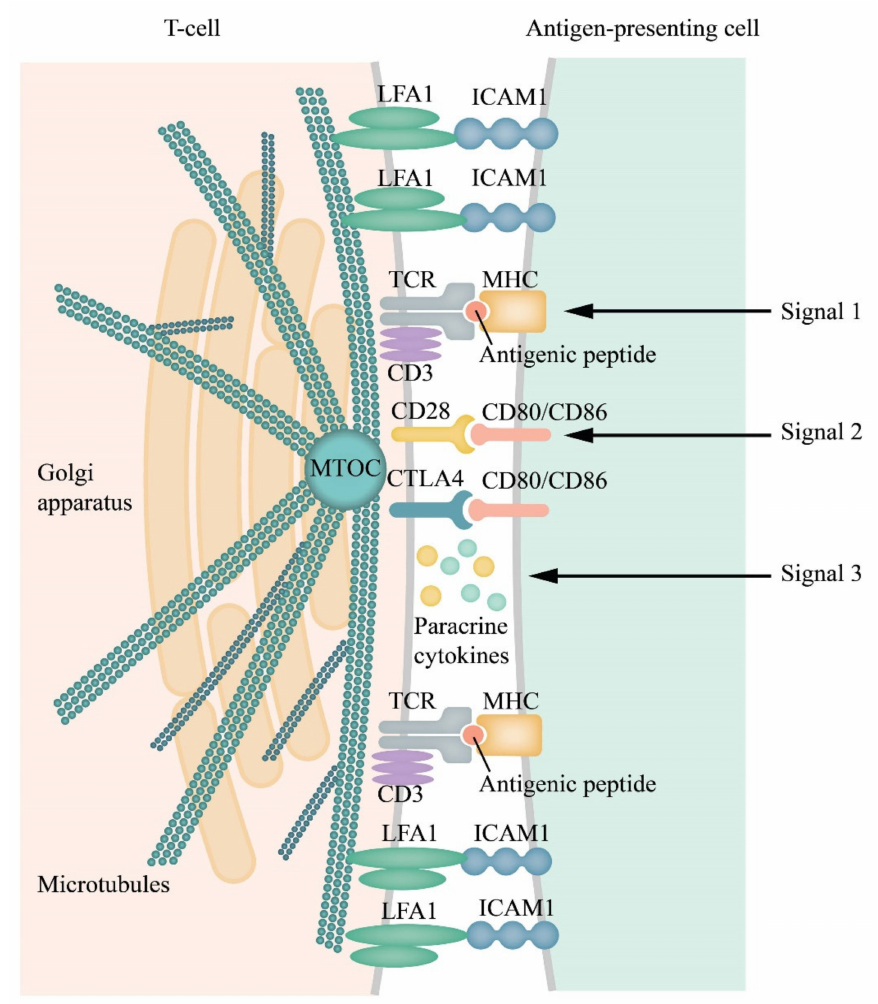
Figure 1. Scheme of an immunological synapse (IS) and receptor / (co-receptor)–ligand interactions within the synapse cleft and distribution of receptors and adhesion molecules in separate clusters within the IS. T cell receptor (TCR) / CD3 complex interacts with an MHC peptide. Adhesion molecules, such as lymphocyte function-associated antigen 1 (LFA-1) and Inter-Cellular Adhesion Molecule 1 (ICAM-1), on the surface of both cells, are responsible for the formation and stabilization of ISs, and initiation of signal pathways generated by the TCRs [47]. The cytoskeleton is remodeled, the Golgi apparatus, and the microtubule-organizing center (MTOC) move to the IS formation region [48,49]. All these rearrangements facilitate and allow the directed secretion within the synapse [49–52]. Activation / inhibition of T cells requires three signals. The first signal is initiated by binding of the TCR complexes with antigen peptides (blue circlet) presented by MHCs of the APCs. The second signal, an antigen-independent stage, is triggered by the interaction of the co-stimulating T cell receptor CD28 with ligands B7.1 (CD80) or B7.2 (CD86), delivered by the APCs (or tumor cells). Paracrine cytokines generate the third signal. All transmembrane contacts are clustered and have been symbolized by their pairs in the